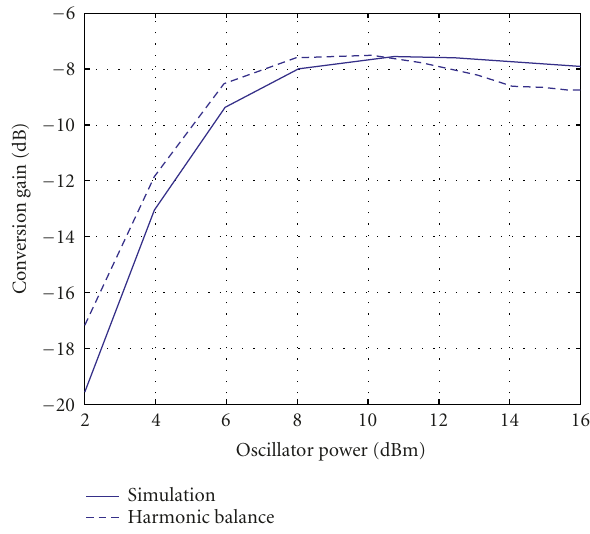
Figure 7: Conversion gain of the EHM using self-biased APDP cal- culated by the harmonic balance method and compared with simu- lated